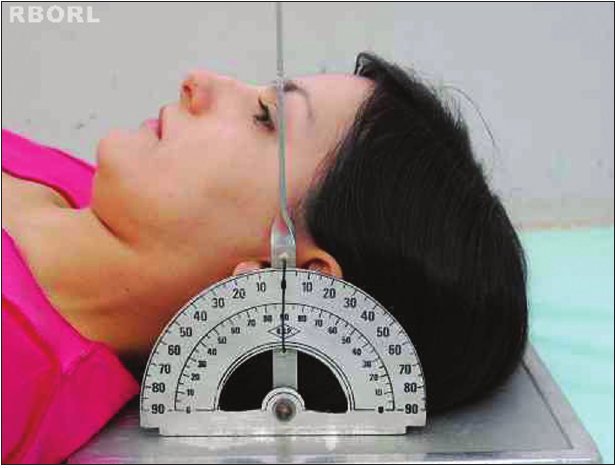
Figura 2. Posicionamento - linha órbito-meatal perpendicular ao filme: Transorbitária (vista